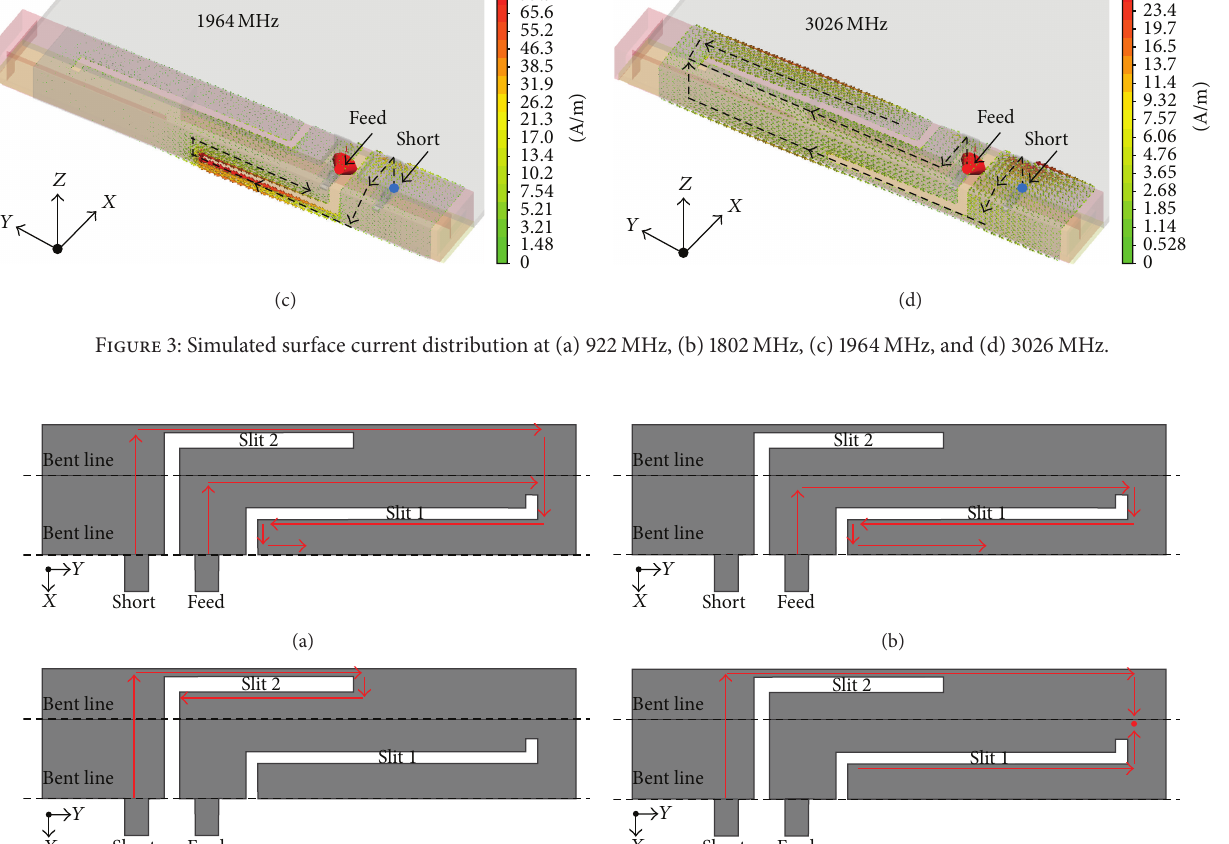
Figure 4: Illustration of the current distribution in an unfolded view: (a) at 922 MHz, (b) at 1802 MHz, (c) at 1964 MHz, and (d) at 3026 MHz.